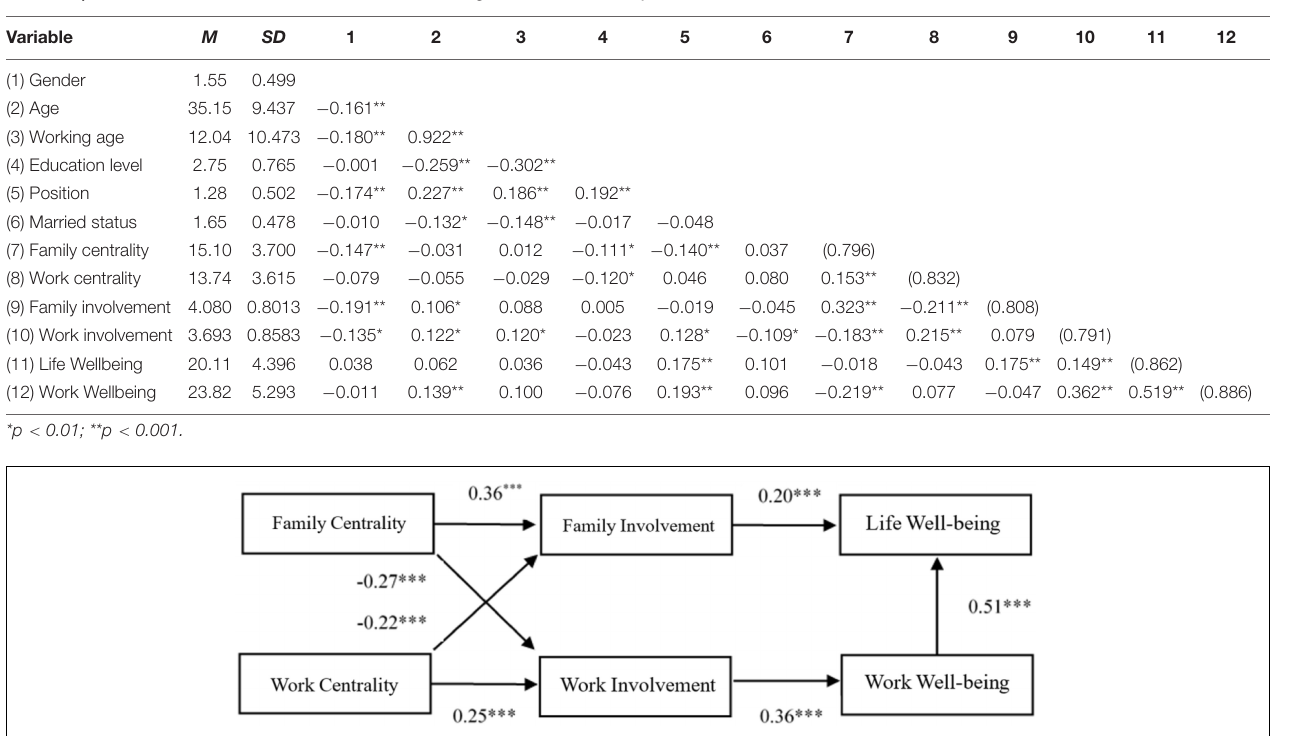
TABLE 5 | Means, standard deviations, and correlations among the variables of study 2. Variable